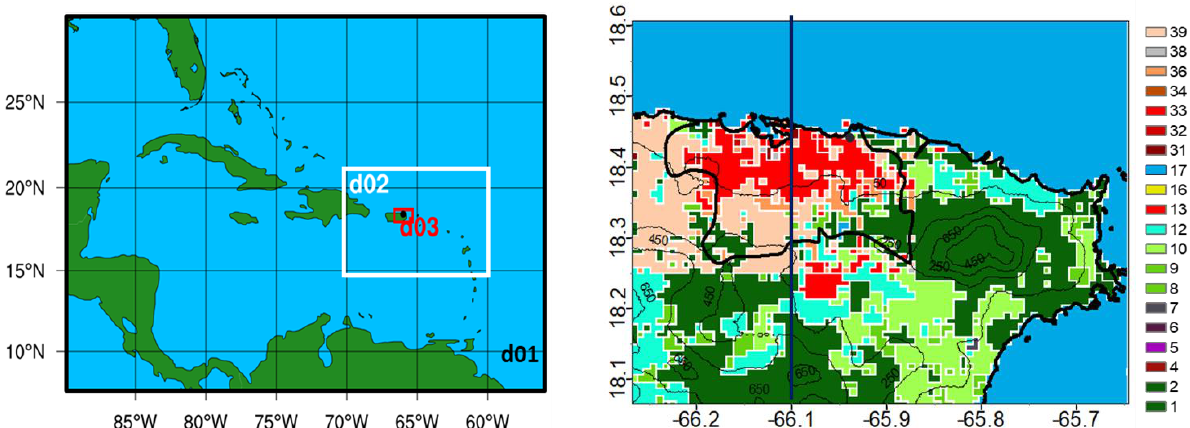
Figure 2. WRF domain configuration ( left ) and finer domain configuration . d01 (whole figure), d02 (white box), d03 (red box) corresponds to domain 1, 2 and 3. ( right ) with MODIS LCLU for natural classes and WUDAPT LCZs for urban classes (2 — evergreen broad leaf forest, 17 — water, and 33 — compact low rise). The vertical black line shows the cross-section passing through − 66.1° lon.